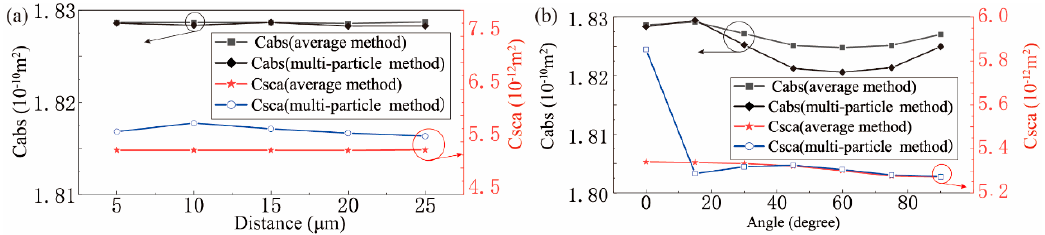
Figure 4. Comparison of the average method between the multi-particle method. ( a ) Resulting curves for C abs and C sca for the case of different distances. ( b ) Resulting curves for C abs and C sca for the case of different angles.